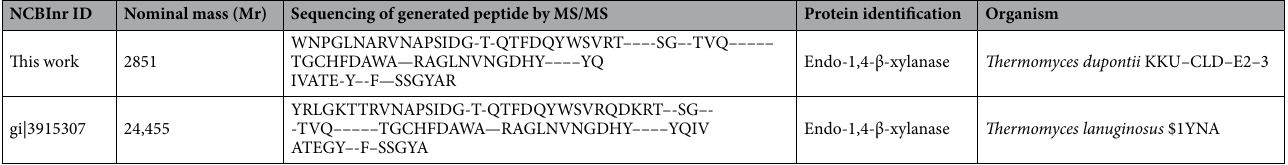
Table 3. Identification of purified xylanase from Thermomyces dupontii